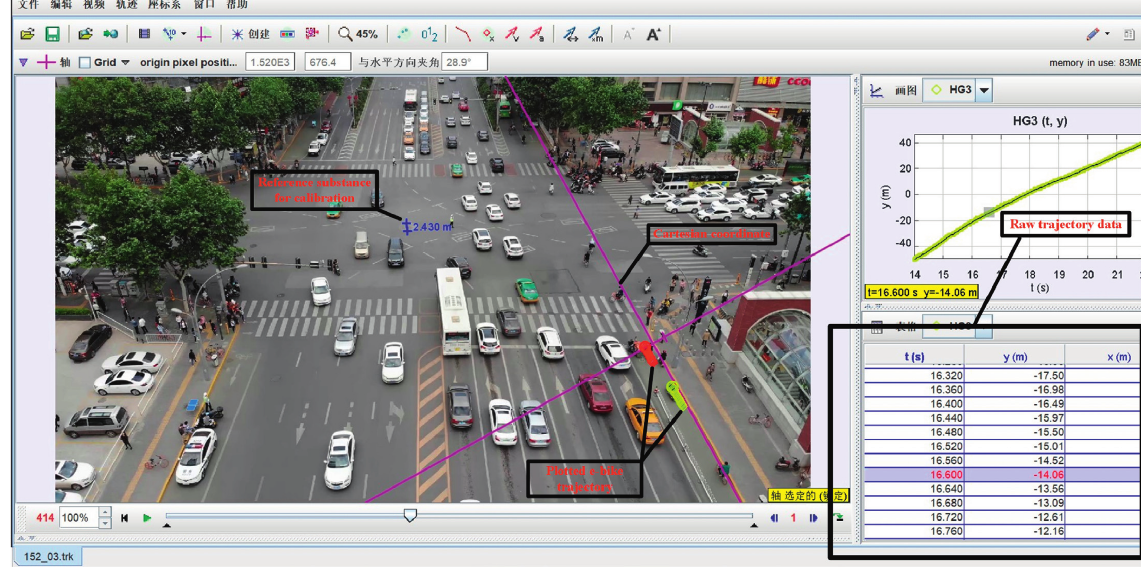
Figure 2: Image of software for data extraction.